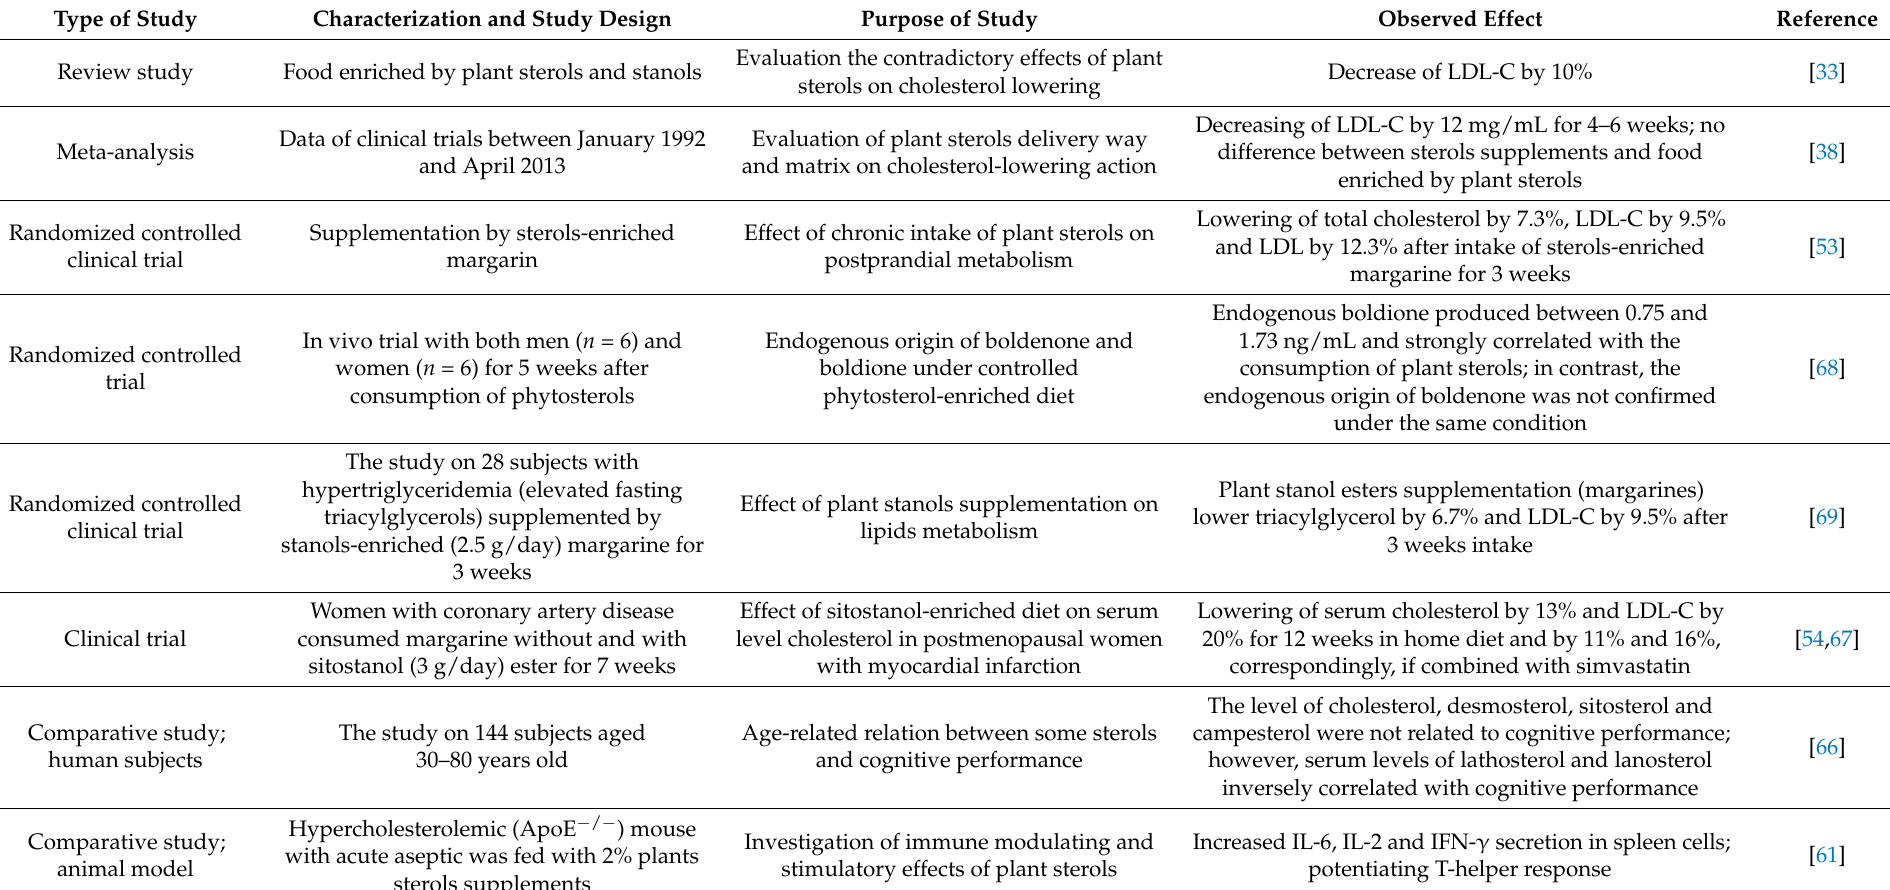
Table 1. Main findings of plant sterols effects in clinics and professional